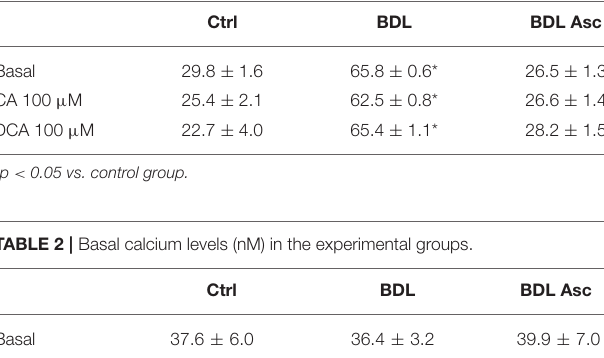
TABLE 1 | P-selectin expression (arbitrary units) in the experimental groups.